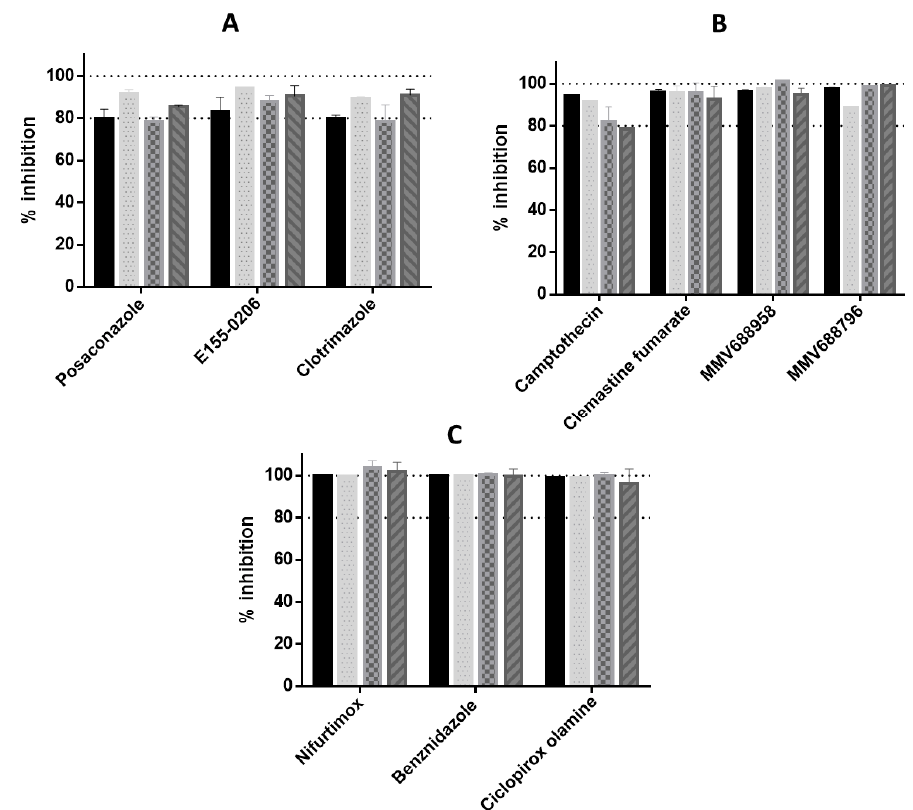
Figure 1. E max values of compounds from differing chemical classes against T. cruzi intracellular amastigotes, from Tulahuen, CL, Y and G strain parasites, following 48 h incubation. ( A ) CYP51 inhibitors ( B ) camptothecin, clemastine fumarate and two compounds from the MMV Pathogen Box collection. ( C ) compounds which cleared 100% of parasites from host cells over all strains: the nitroheterocyclic inhibitors benznidazole and nifurtimox; and the antifungal, ciclopirox olamine. Solid bars = Tulahuen strain parasite, dotted bars = CL strain, chequered bars = Y strain, striped bars = G strain. Dashes shown at 80% and 100% activity.